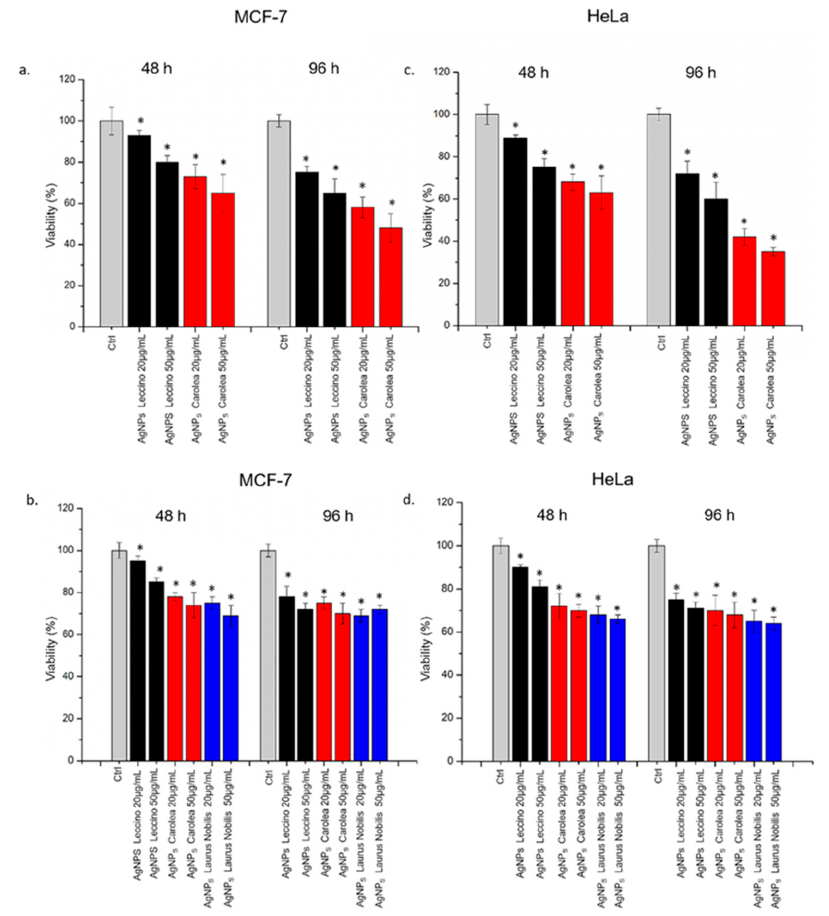
Figure 7. WST-8 of MCF-7 and HeLa cells after 48 h and 96 h exposure to two doses (20 µ g / mL and 50 µ g / mL) of AgNPs derived from Oleaea Europeae ( Leccino and Carolea ) at pH 7 ( a and c ) and from Oleaea Europeae ( Leccino and Carolea ) and Laurus Nobilis at pH 8 ( b and d. ) Viability of NPs-treated cells was normalized to non-treated control cells. As positive control (P), cells were incubated with 5 % Dimethyl Sulfoxide (DMSO) (data not shown). Data reported as mean ± SD from three independent experiments are considered statistically significant compared with control ( n = 8) for p value ˂ 0.05 (< 0.05 *).